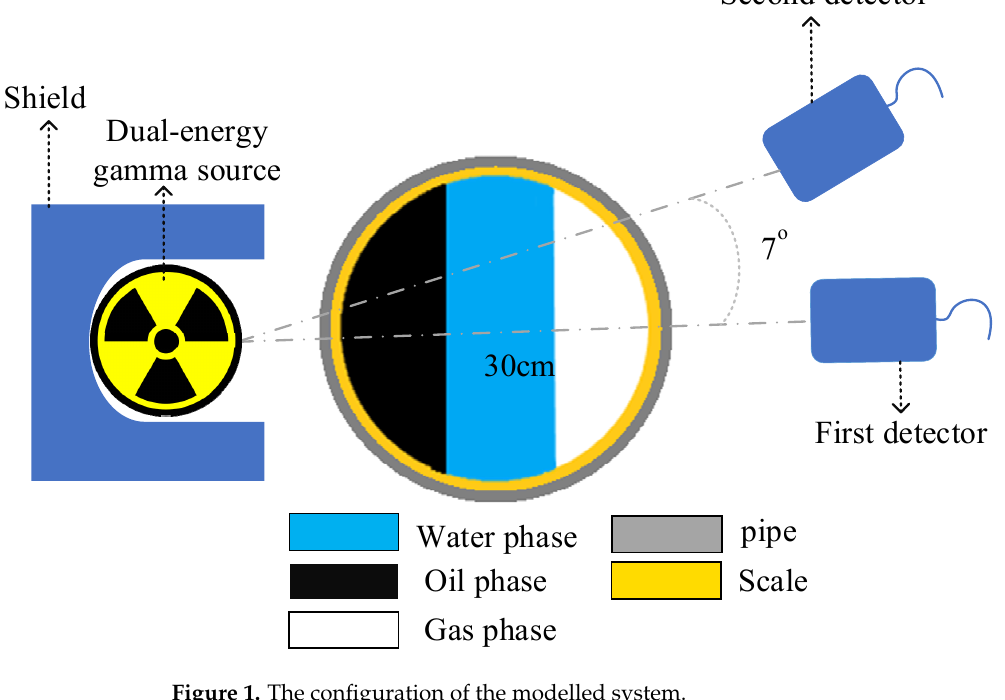
Figure 1. The configuration of the modelled system.